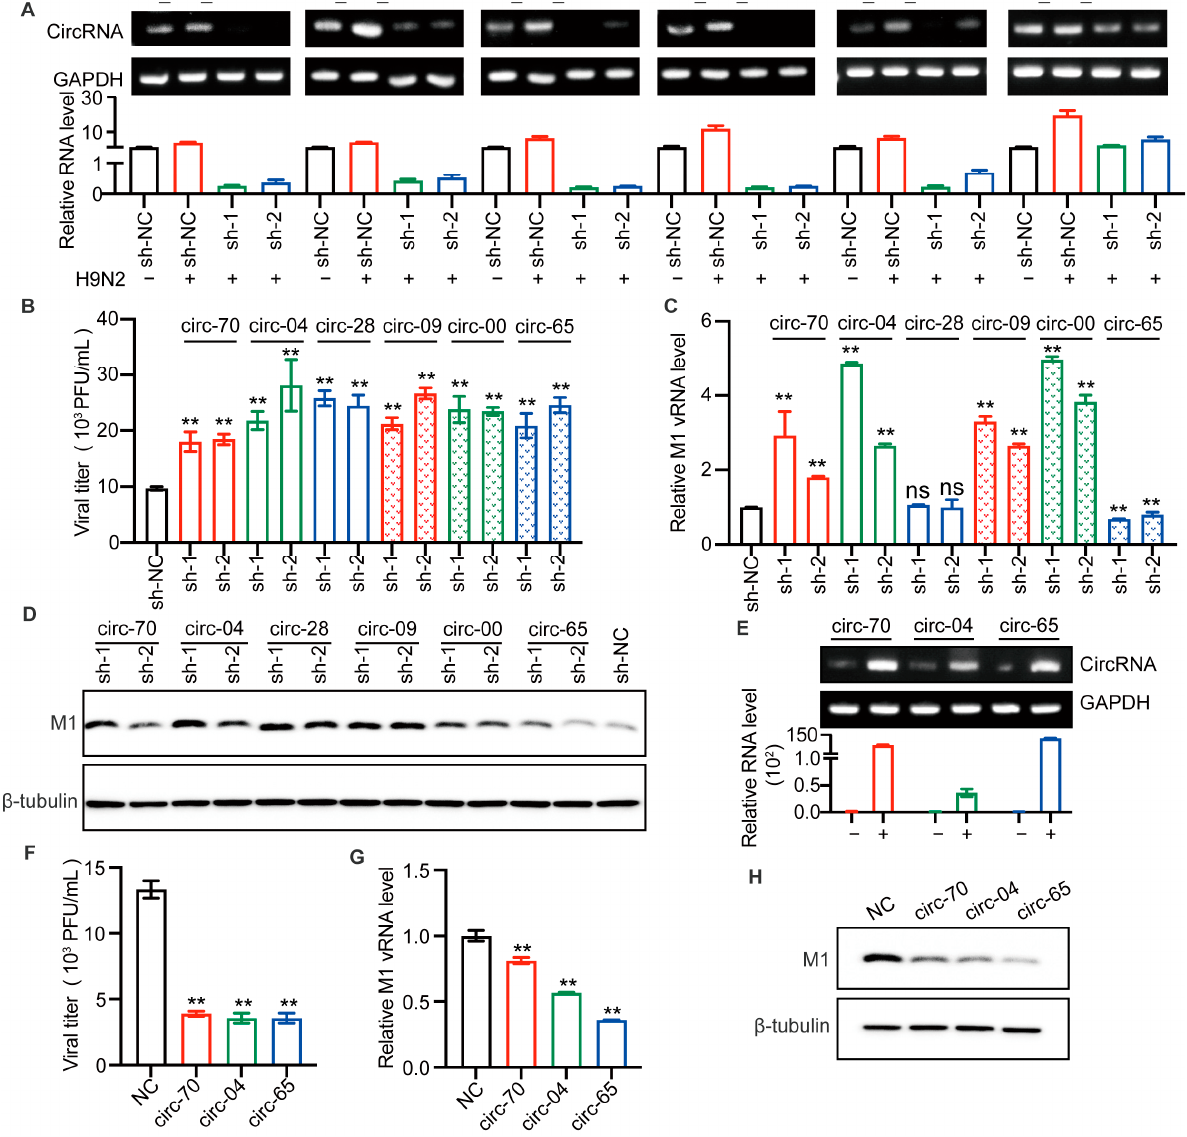
Figure 4. Selected circRNAs affect H9N2 virus replication. ( A – D ) The candidate circRNAs in A549 cells were silenced by lentiviral packaged shRNAs for 48 h and then infected with H9N2 virus at 12 h (MOI = 0.5). ( A ) The levels of the six circRNAs were detected by RT-qPCR ( n = 3) and visualized by agarose gel electrophoresis. Data were normalized to GAPDH and expressed as mean ± SD. “ − ” stands for PBS treatment, and “+” indicates treatment with H9N2 virus. ( B ) The virus titer in supernatants was measured by plaque assays, ** p < 0.01. ( C ) The level of AIV M1 vRNA was detected by RT-qPCR ( n = 3). Data were normalized to GAPDH and expressed as mean ± SD. ( D ) Cell lysates were harvested for Western blotting assays using the indicated antibodies. ( E – H ) Overexpression of the indicated circRNAs in 293T cells by plasmid transfection for 24 h, followed by H9N2 virus infection at 12 h (MOI = 0.5). ( E ) The overexpression levels of the circRNAs were detected by RT-qPCR ( n = 3) and visualized by agarose gel electrophoresis. Data were normalized to GAPDH and expressed as mean ± SD. “ − ” stands for PBS treatment, and “+” indicates treatment with H9N2 virus. Cell supernatants were harvested for virus titers ( F ), and for RT-qPCR ( n = 3) to detect the expression level of viral M1 vRNA ( G ), and the remaining cell lysates were used for immunoblotting for viral M1 protein ( H ). Data were normalized to GAPDH and expressed as mean ±